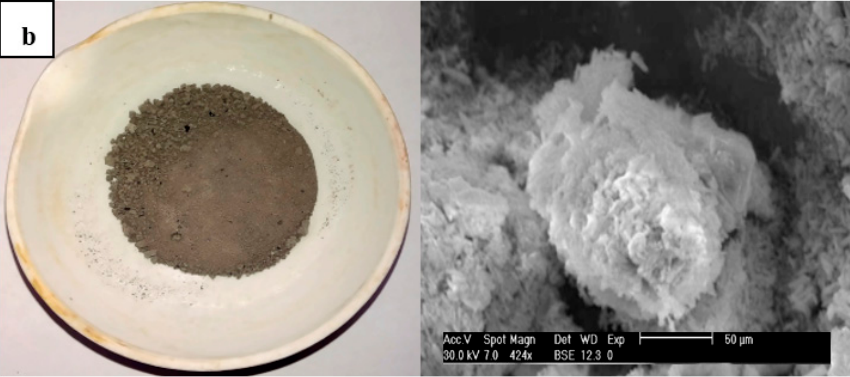
Figure 15. Microstructure of ( a ) zircon concentrate. ( b ) Fused products after NaOH alkali fusion.